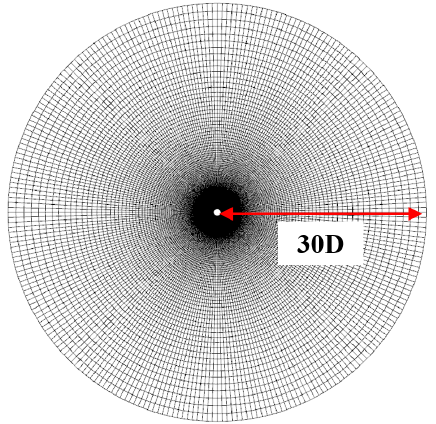
Figure 6. Grid for flow around two-dimensional circular